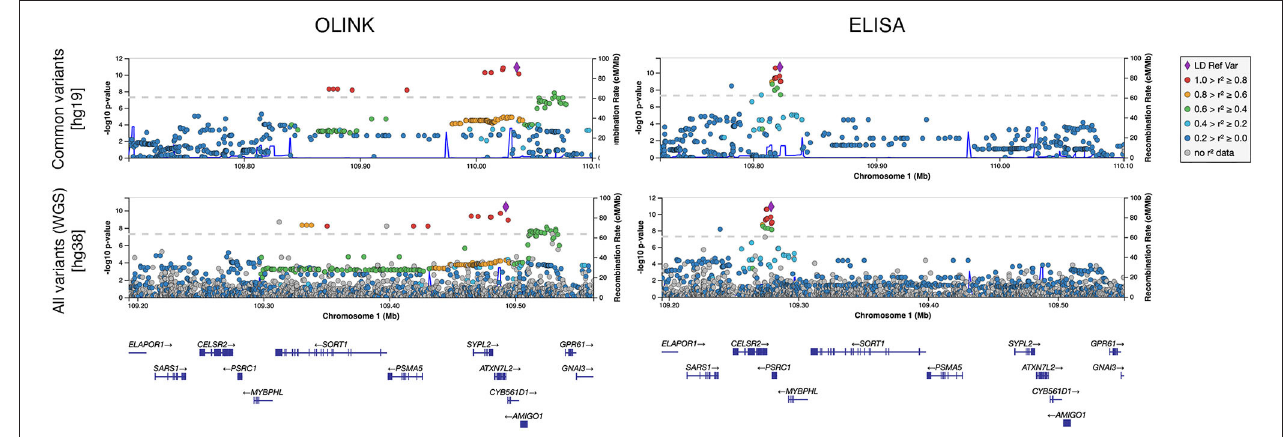
FIGURE 3 | Regional plot of pQTLs identified for sortilin measured with OLINK and ELISA for common variants (MAF > 0.05) and for all segregating variants identified by whole-genome sequencing